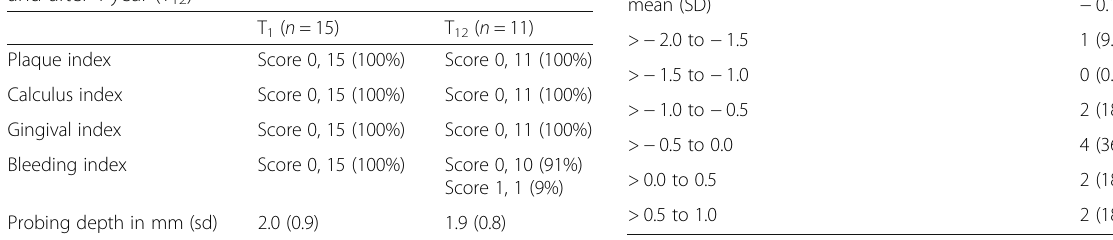
Table 2 Frequencies and percentages of plaque index scores (possible score 0 – 3), calculus index scores (possible score 0 – 1), gingival index scores (possible score 0 – 3), bleeding index scores (possible score 0 – 3), and mean value and standard deviation of probing depth (in mm) 1 month after restoration placement (T 1 )